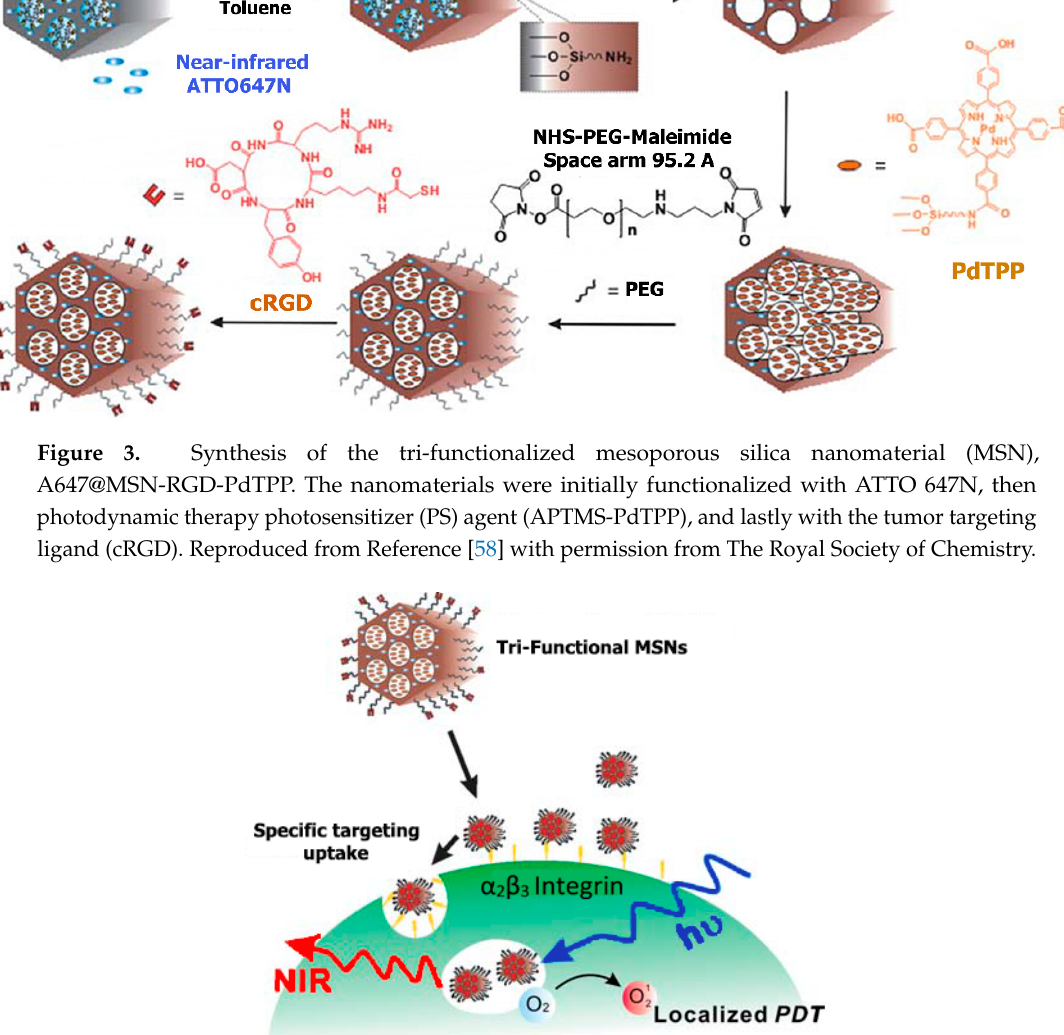
Figure 4. Tri-functionalized mesoporous nanomaterials employed as theranostic compounds that possess distinctive domains for localized photodynamic therapy photosensitizers, traceable imaging, as well as capable targeted delivery. Reproduced from Reference [58] with permission from The Royal Society of Chemistry.